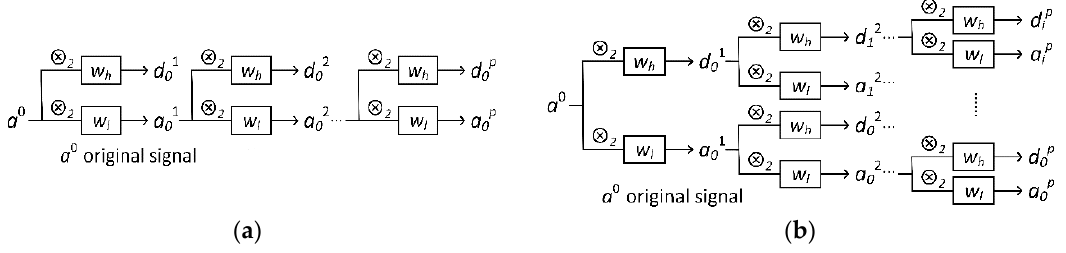
Figure 2. The decomposition tree of ( a ) wavelet transform; ( b ) wavelet packet transforms.